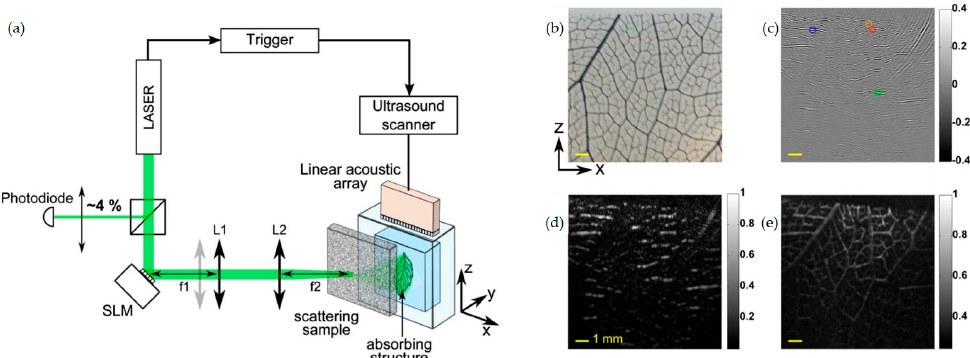
Figure 8. ( a ) Experimental setup for PAWS (transmission matrix measurement approach); ( b ) reference photograph of the absorbing leaf skeleton embedded in a transparent agarose gel block; ( c ) a standard photoacoustic image obtained by averaging different speckle illuminations and its envelope ( d ); and ( e ) enhanced photoacoustic imaging with PAWS optimization.